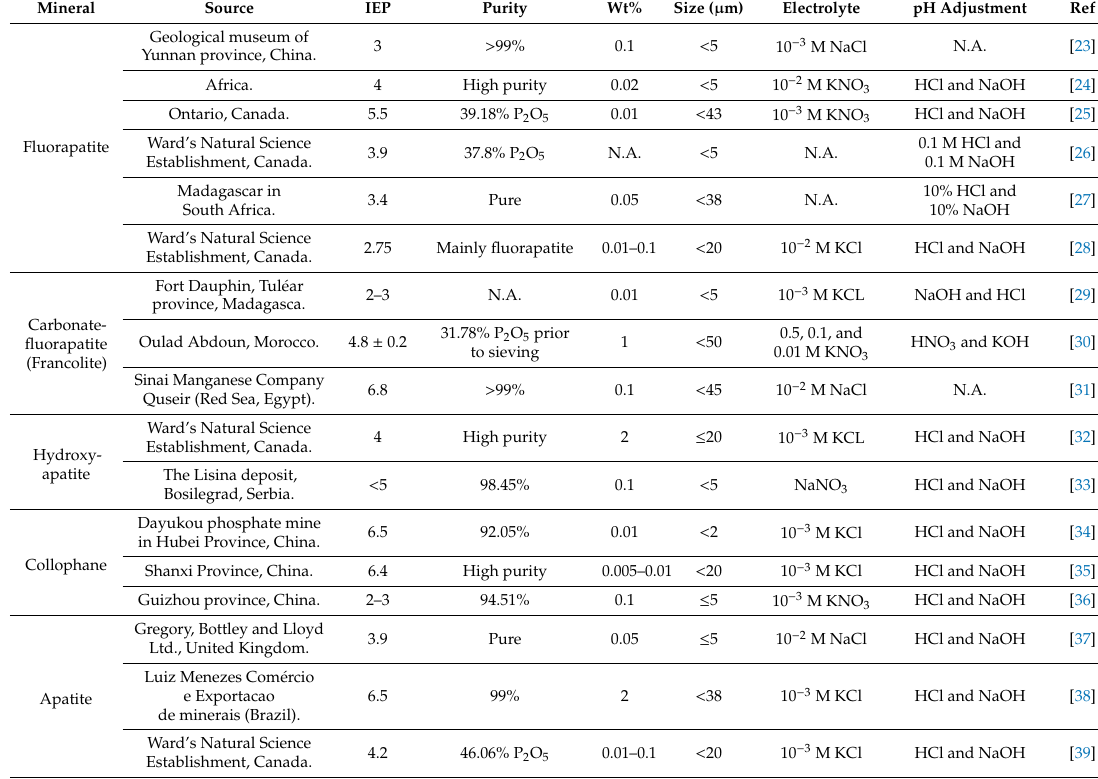
The isoelectric point (IEP) values of phosphate minerals and their measurement operating